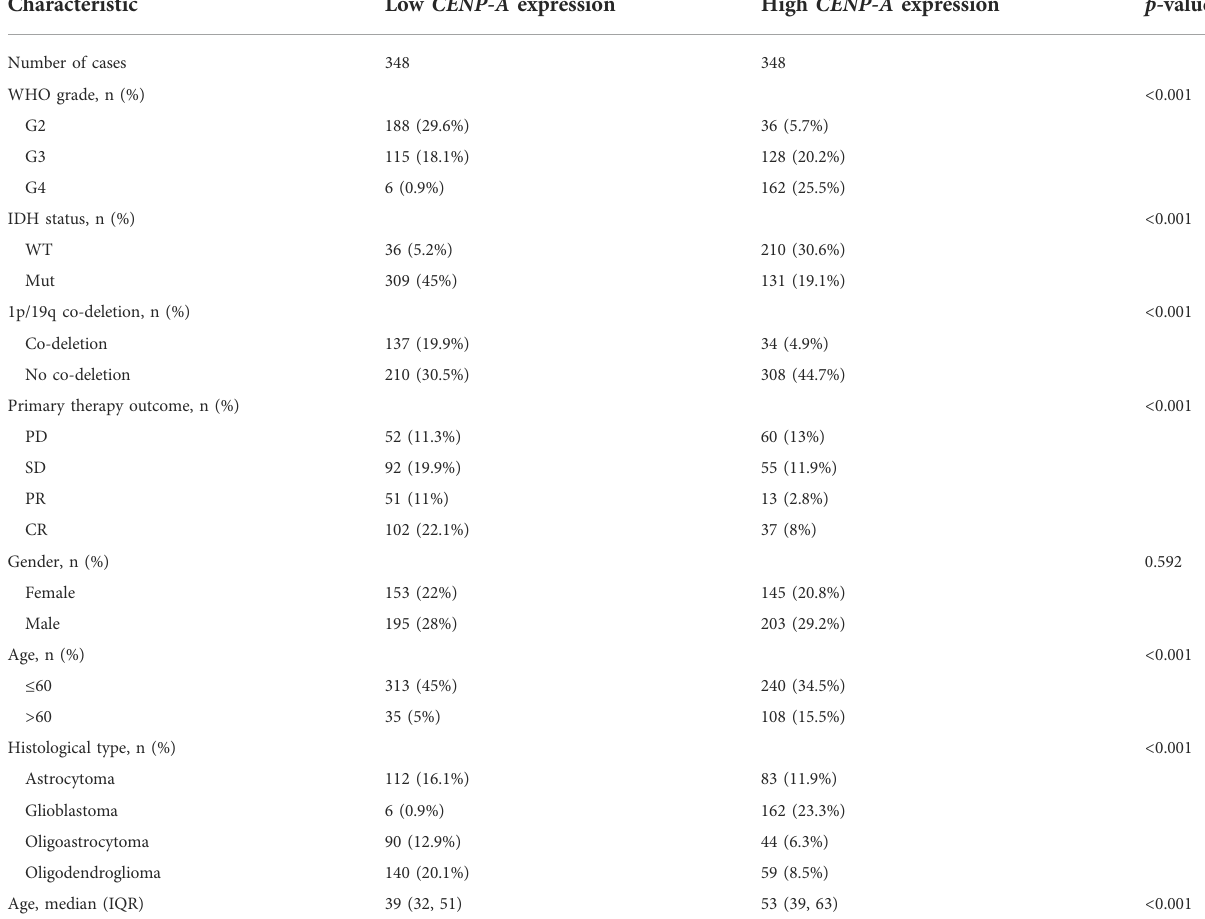
TABLE 1 Clinical characteristics of patients with glioma from